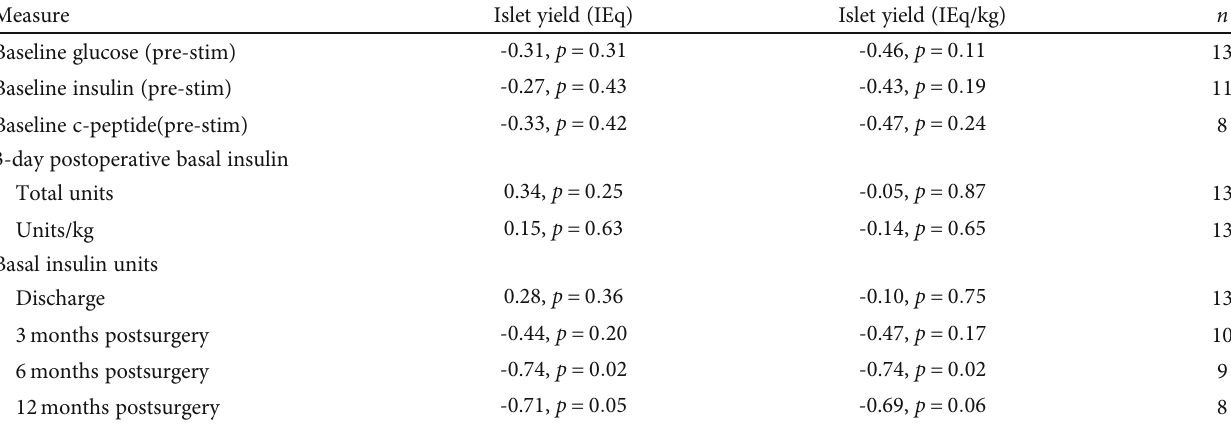
Table 2: Correlations with islet yield. Pearson correlation coe ffi cients ( r , p value, n ).